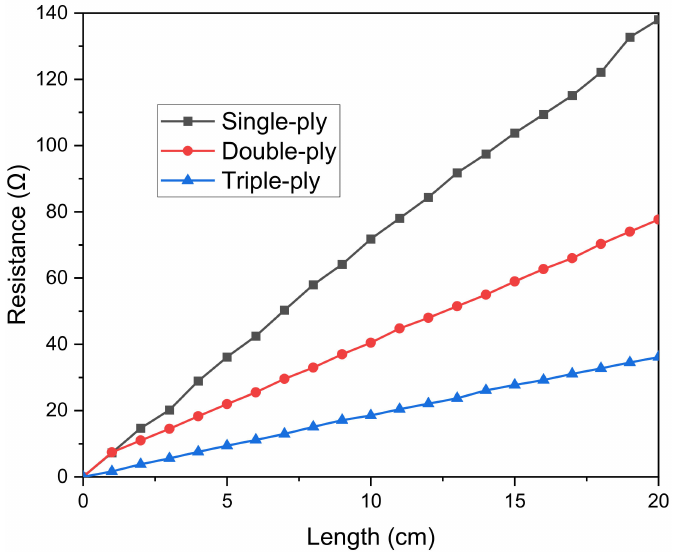
Figure 4. Effect of single-ply, double-ply and triple-ply thread length on the resistance